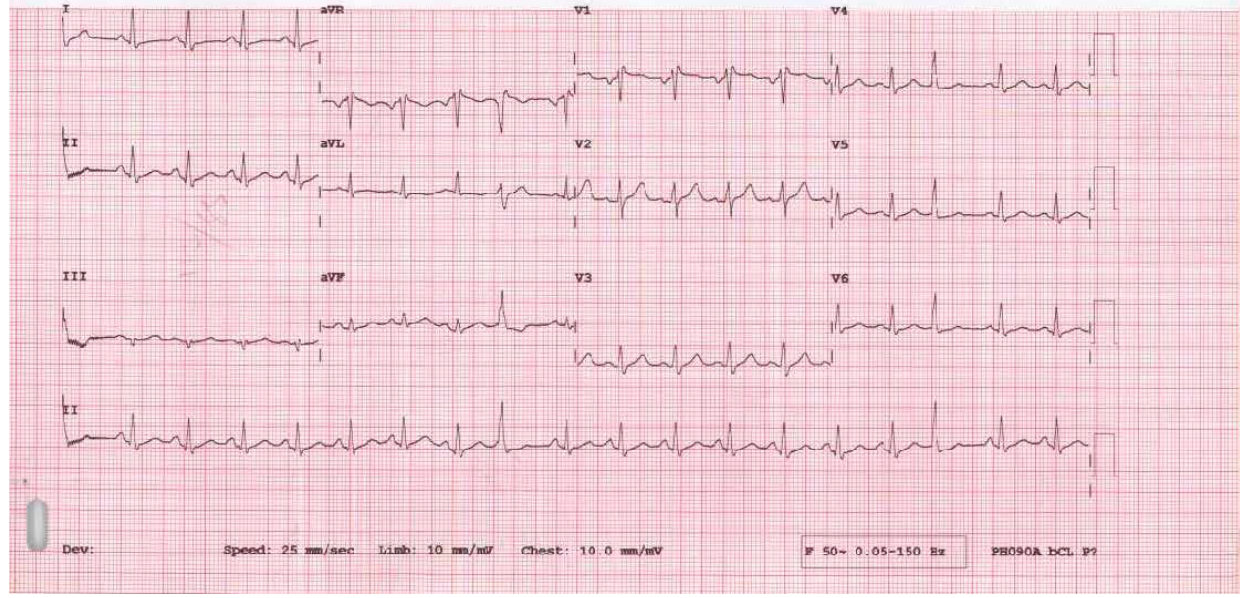
Figure 2: ECG showing sinus tachycardia with premature ventricular